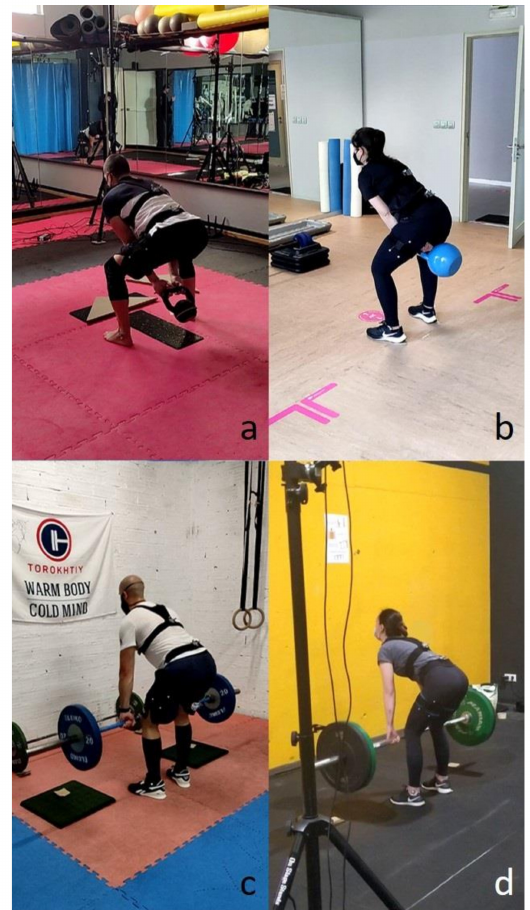
Figure 6. Experimental measurements during lifting exercises in four gym centers. ( a , b ): During American kettlebell swing; ( c , d ): During